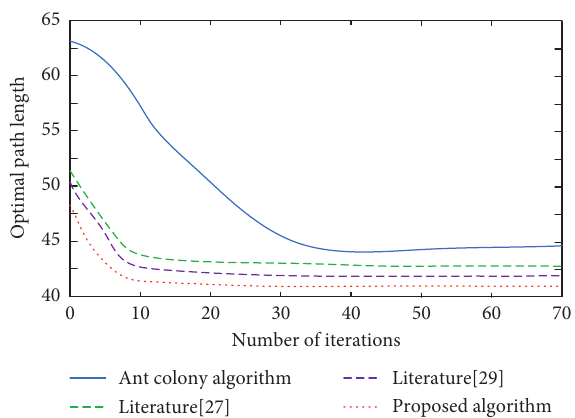
Figure 7: Comparison of convergence curves.